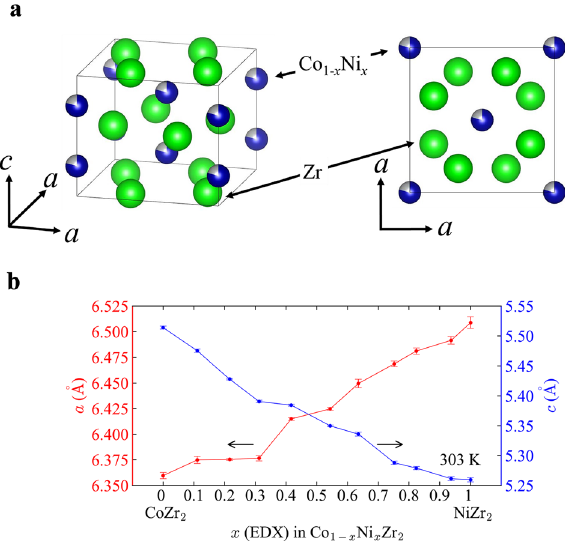
Figure 1. ( a ) Schematic images of the crystal structure of Co 1− x Ni x Zr 2 . ( b ) Ni concentration ( x ) dependence of lattice constants a and c at 303 K. The error bars are standard deviations estimated by the Rietveld